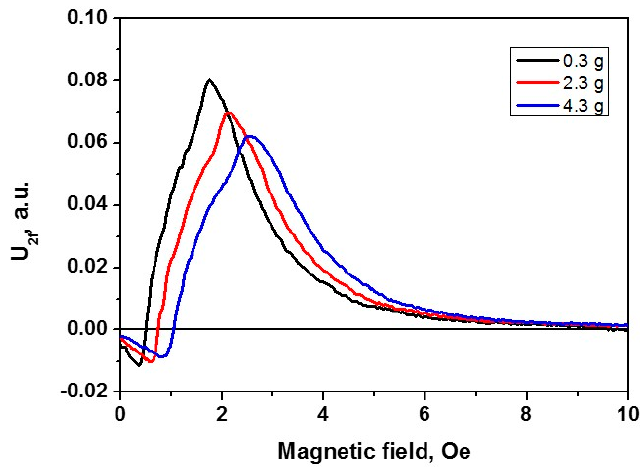
Figure 6. AMR curves at the driving current of 2 mA and various mechanical loads.